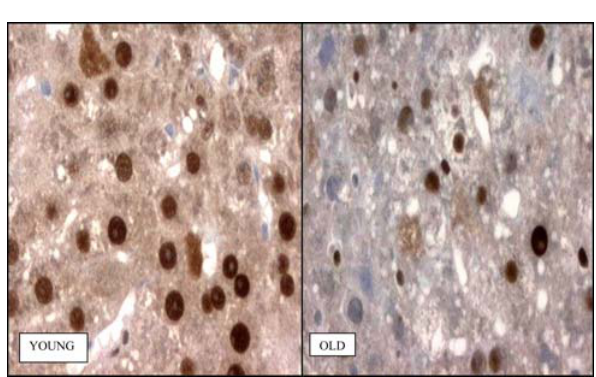
FIGURE 5 - Photomicrographs of histological liver cuts in young and old animals after 24 hours